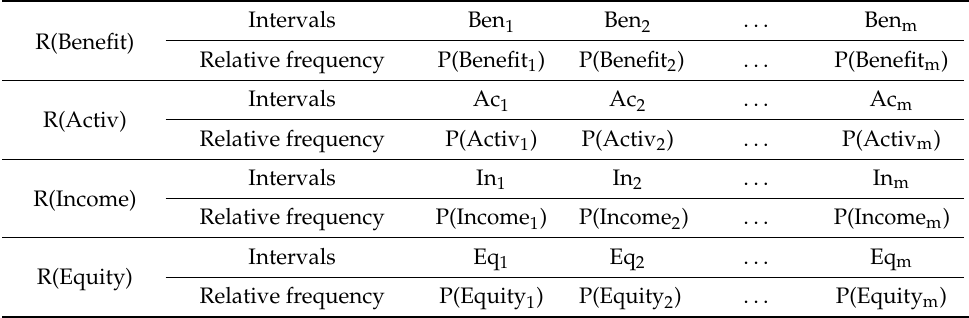
Table 1. Laws of distribution of random variables Benefit , Activ , Income , Equity